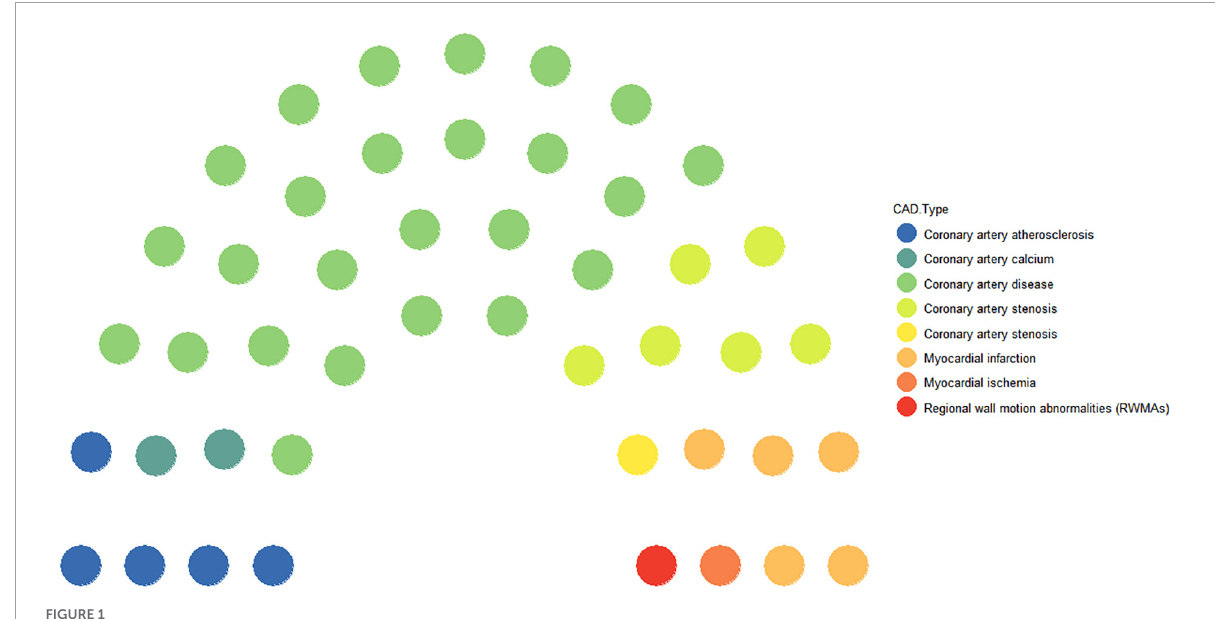
FIGURE1 CAD types in the included publications.